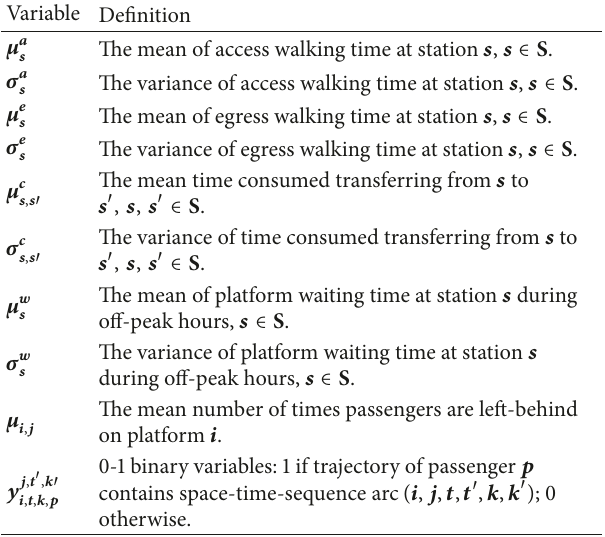
Table 2: Estimation